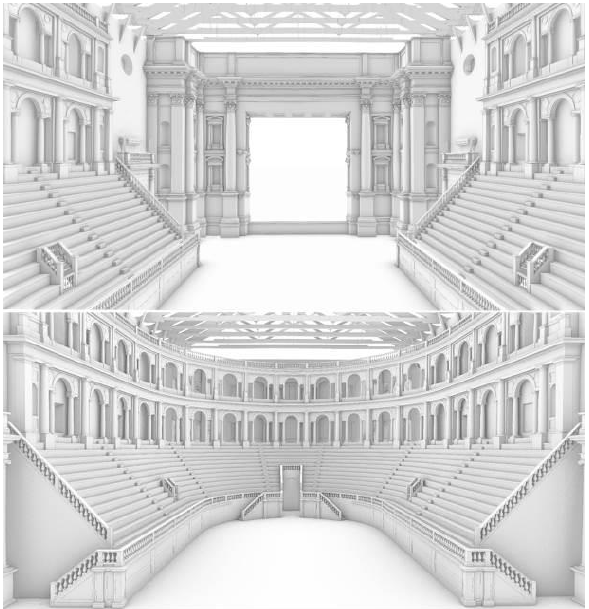
Figure 6 . 3D model of the Farnese Theatre (above: view of the proscenium, below: view of the